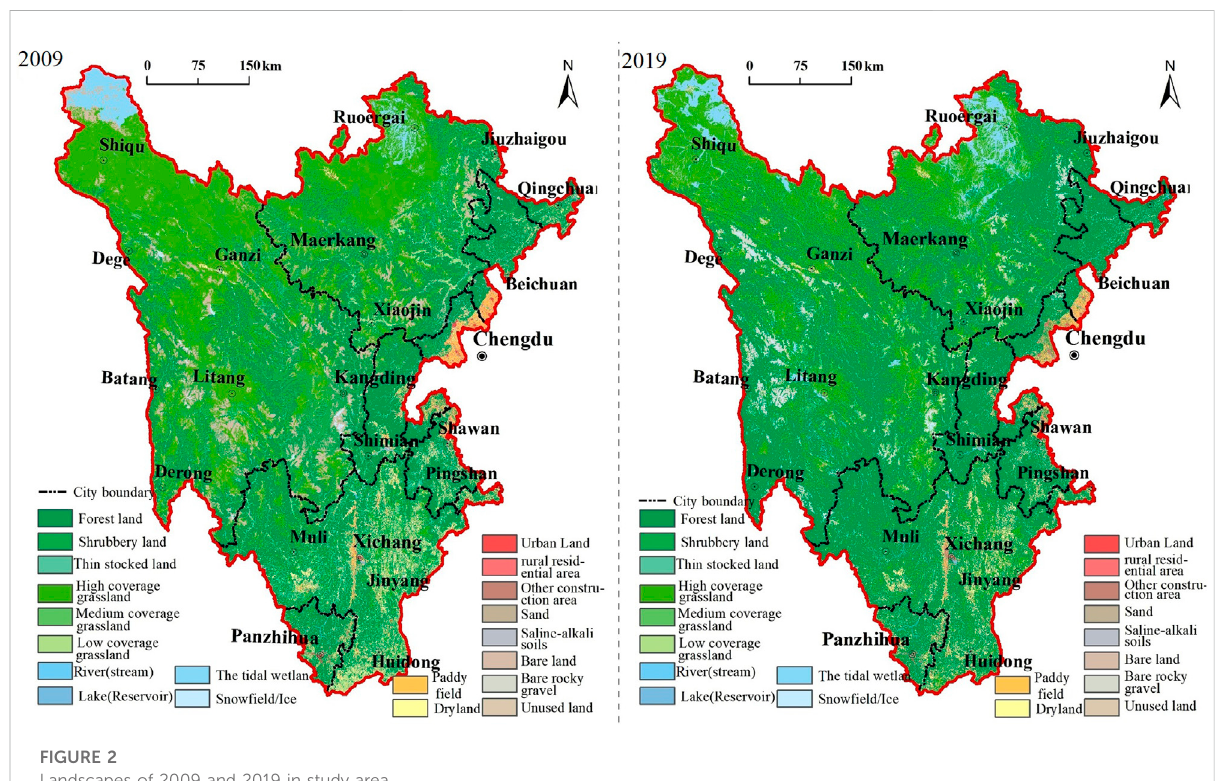
FIGURE 2 Landscapes of 2009 and 2019 in study